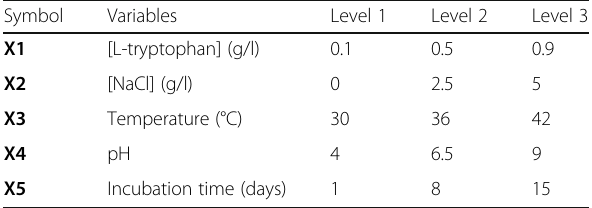
Table 1 Factors and their levels used in the optimization of IAA production by Rhizobium sp. using the central composite